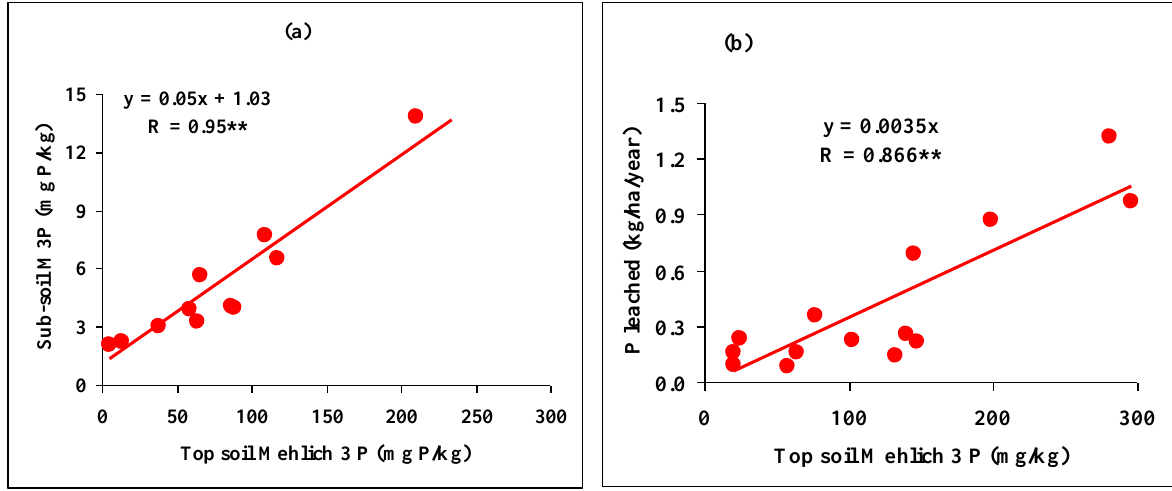
FIGURE 6. Relationship between Mehlich-3 P extractable from the topsoil vis-a-vis (a) subsoil Mehlich-3 P and (b) total P leached.